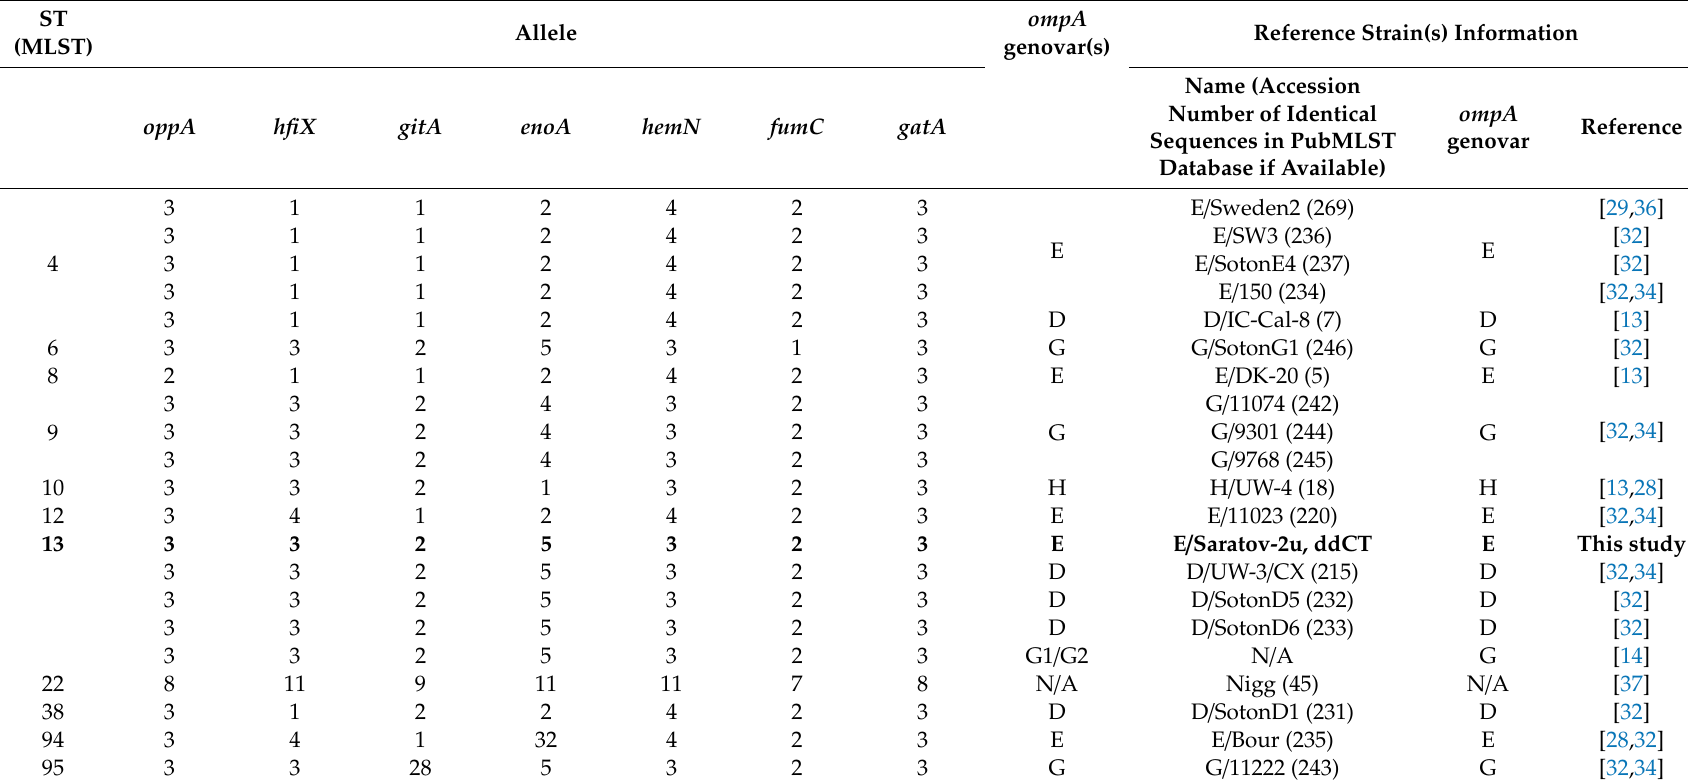
Table 2. The ompA and seven housekeeping genes MLST sequence types of ddCT, nvCT and reference strains of C. trachomatis obtained from the PubMLST database (Available online: https: //